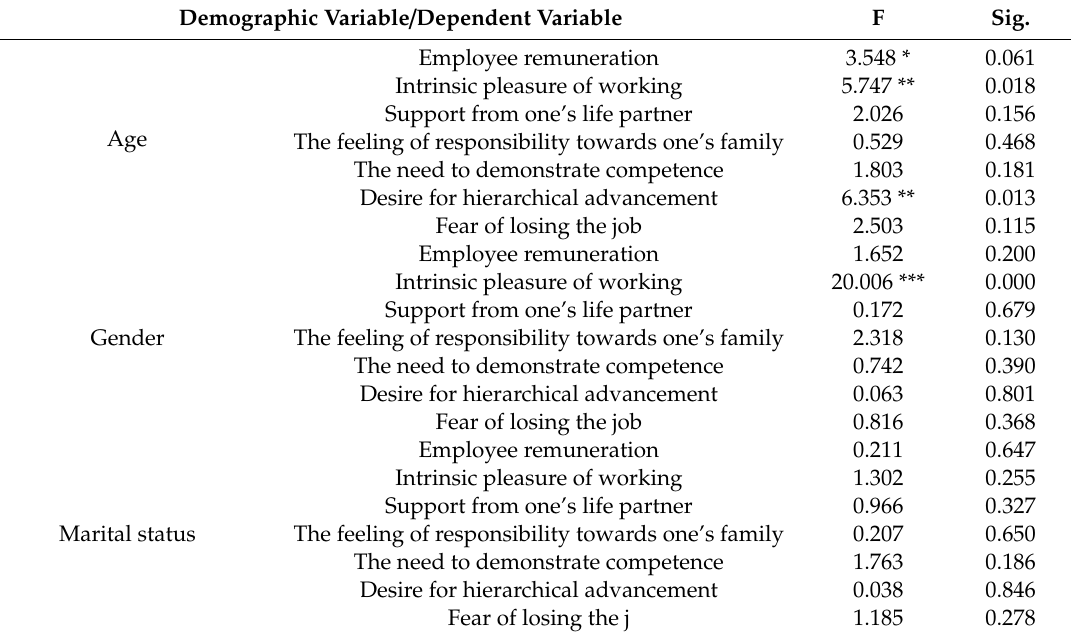
Table 7. The demographic variables—the contribution in the prediction of dependent